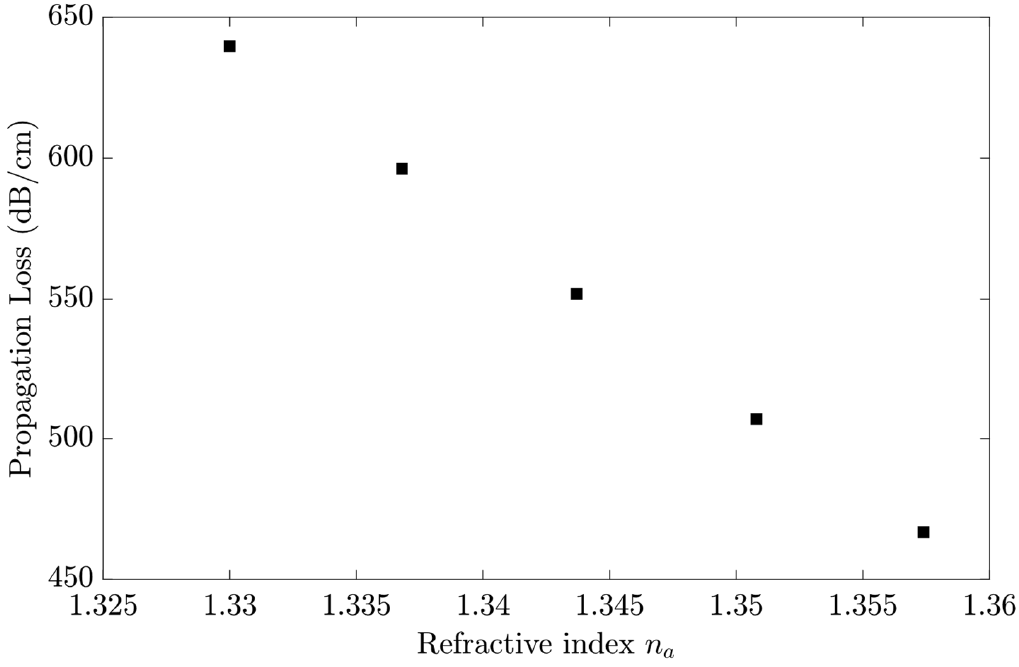
Figure 12. The LRSPP propagation loss shift versus the refractive index of different glycerol concentrations for λ 0 = 633 nm.